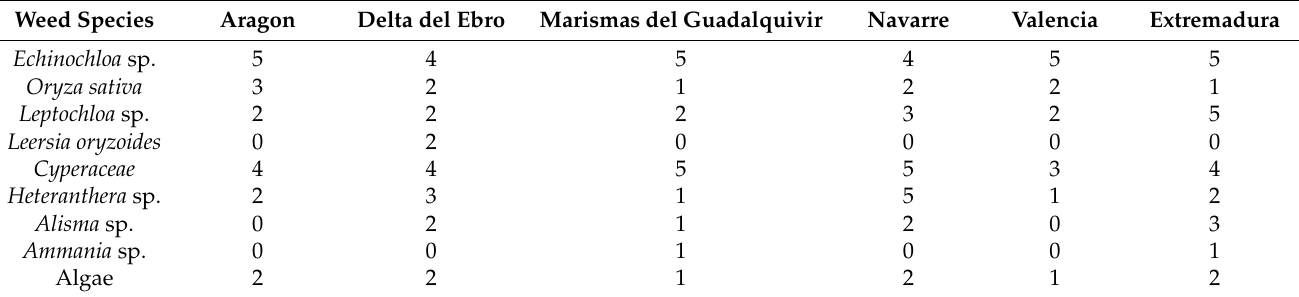
Table 4. Infestation level * of rice weeds in the six main Spanish rice areas, based on an evaluation by a panel of experts classifying weed species into five